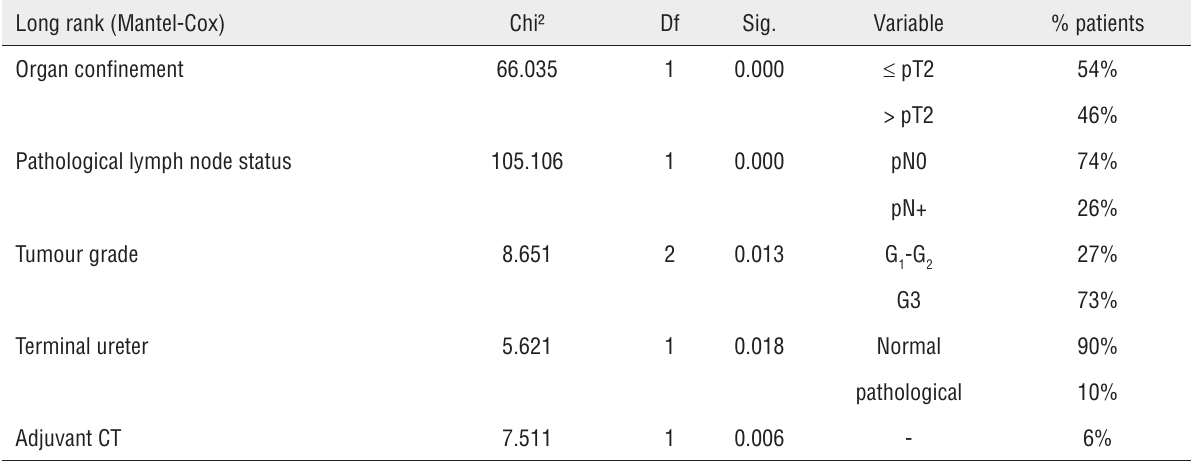
Table 3 - Univariante analysis of predictive factors for PFS. Long rank (Mantel-Cox) Chi² Df Sig. Variable % patients Organ confinement 66.035 1 0.000